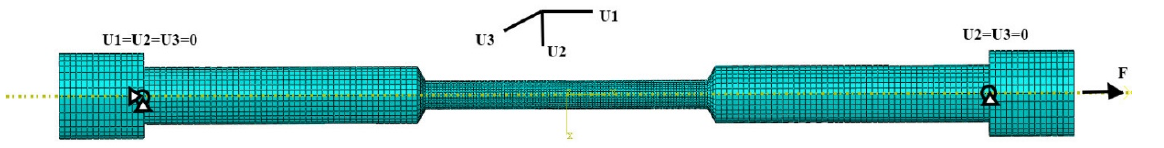
Figure 16. Mesh and boundary conditions used for numerical modeling of smooth tensile specimens.